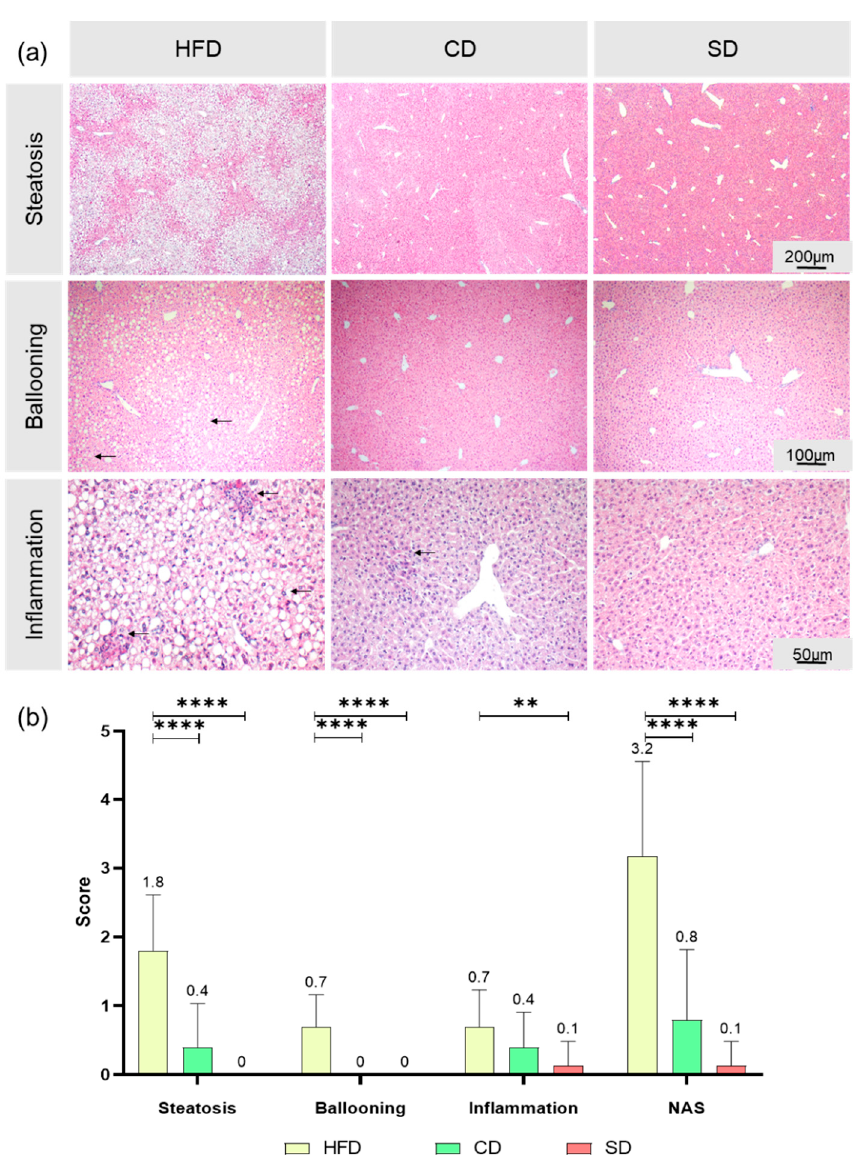
Figure 5. ( a ) Representative images of steatosis (50 × magnification, scale bar represents 200 µm valid for all three images), ballooning (100× magnification, scale bar representing 100 µm valid for all three images) with black arrows indicating damaged cells, and inflammation (200× magnification, scale bar representing 50 µm valid for all three images) with black arrows indicating inflammatory foci in livers from mice fed high fat diet (HFD), control diet (CD) or standard diet (SD); ( b ) Assessments of scores for steatosis, ballooning and inflammation as well as calculation of NAS for the groups (HFD: n = 29; CD: n = 15, SD: n = 15). Data presented as mean ± standard deviation. Significance of differences between the groups was tested by one-way ANOVA on Ranks (Kruskal–Wallis); **** p < 0.0001, ** p < 0.01.